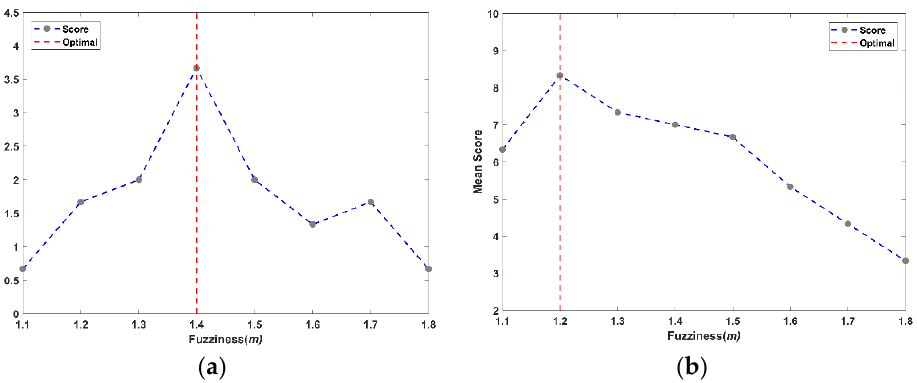
Figure 6. Example results from the determination of m using the optimal number of clusters for data reduction for ( a ) increment A and ( b ) increment B.